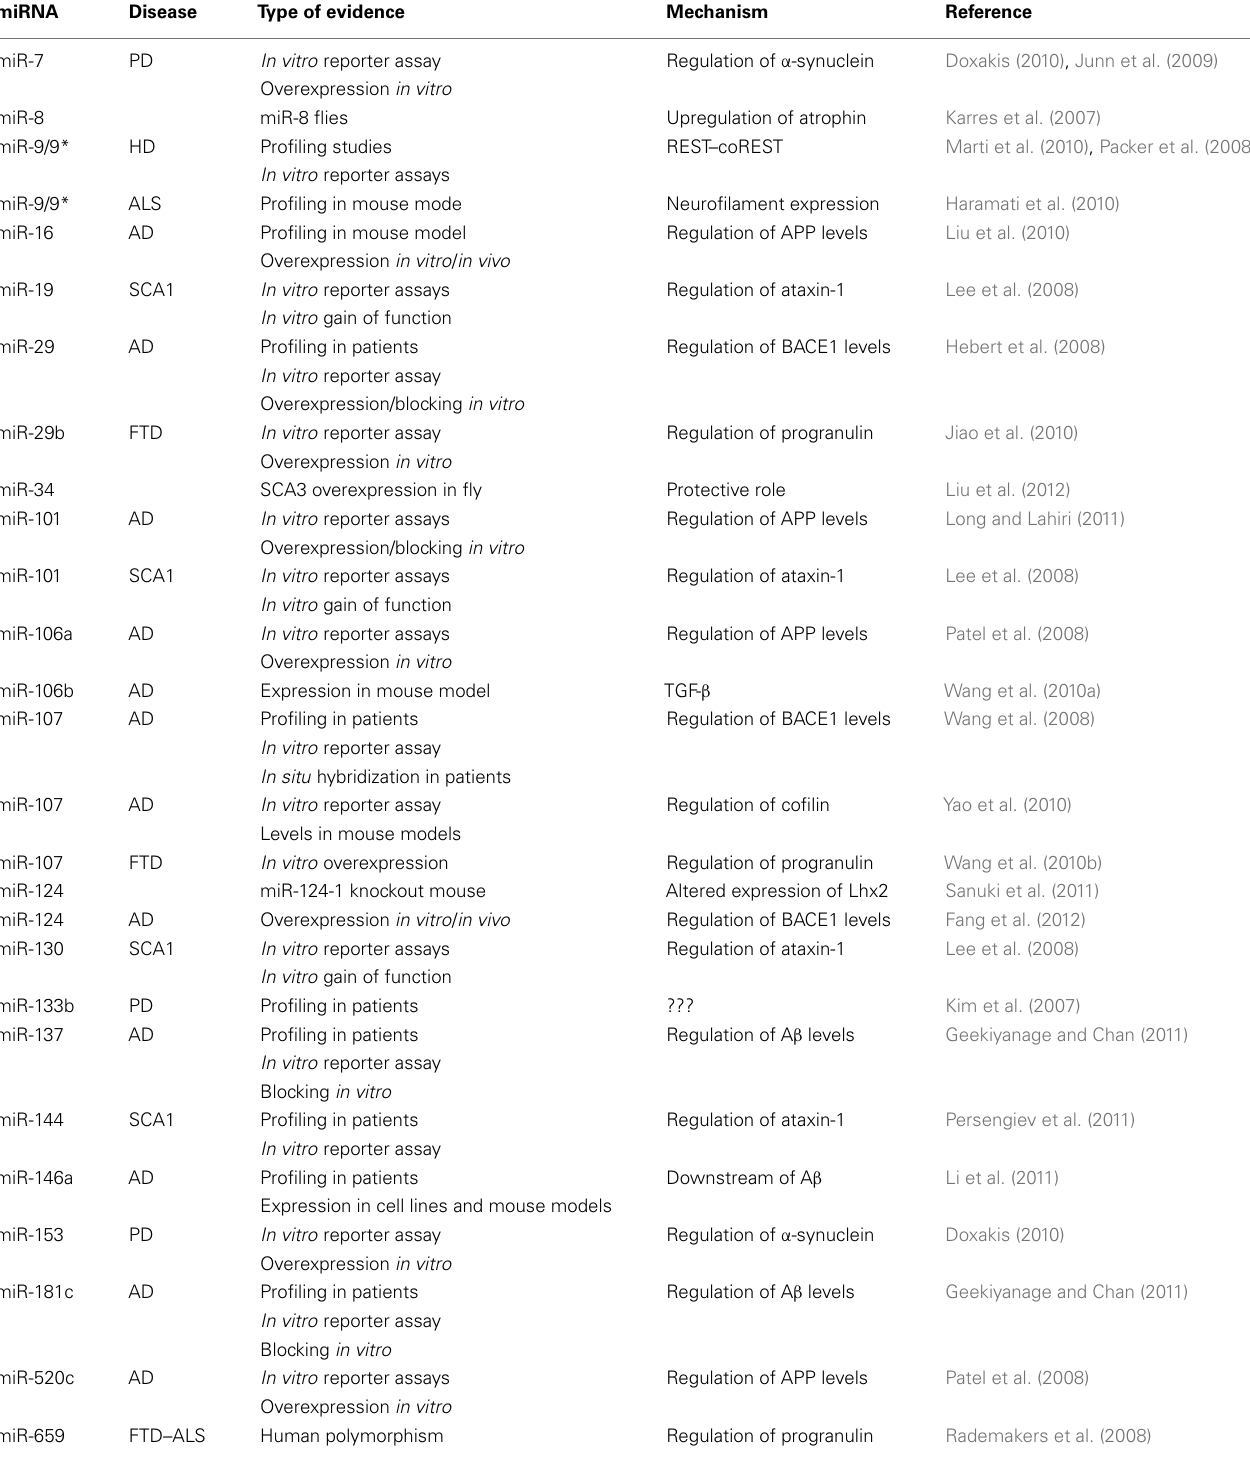
Table 1 | List of miRNAs and the neurodegenerative diseases to which they have been associated. miRNA